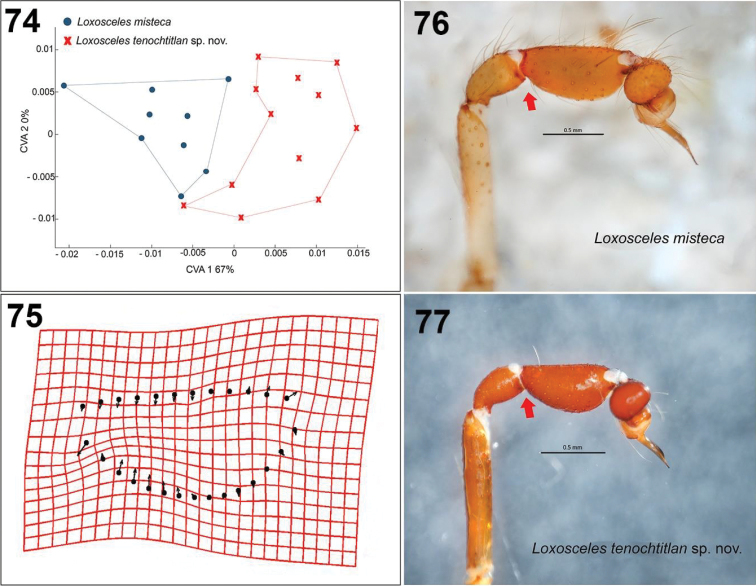
Geometric morphometry of the tibia shape on retrolateral view of the palps of males of L.
tenochtitlan sp. nov. (N = 12) and L.
misteca (N = 9) 74CVA plot showing a significant difference (χ2 = 10.2555, df = 2, p = 0.00593003, λ = 0.5988) between both species in the tibiae shape 75 deformation grid, the vectors indicate the direction of change in the tibia with respect to the average shape of the 21 individuals analyzed of both species 76, 77 palps of the males of L.
misteca and L.
tenochtitlan sp. nov. respectively, retrolateral views (red arrows indicate the change in the shape of the tibiae of the species analyzed).